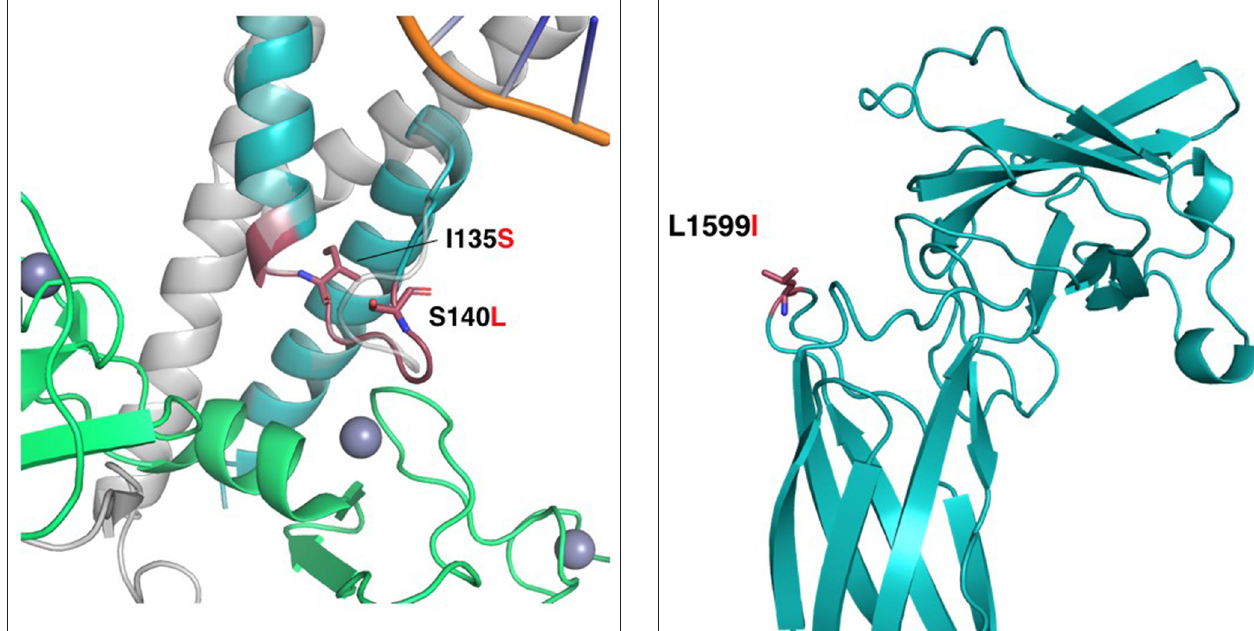
FIGURE 6 | Homology model of the HLH domain from TWIST1. HLH motif (colored teal), superimposed to the SCL protein in the crystal structure of the human SCL:E47:LMO2:LDB1 complex bound to DNA (PDB ID 2YPA). LMO2 is colored green. The Lys133-Pro139 duplication is shown as a red cartoon,